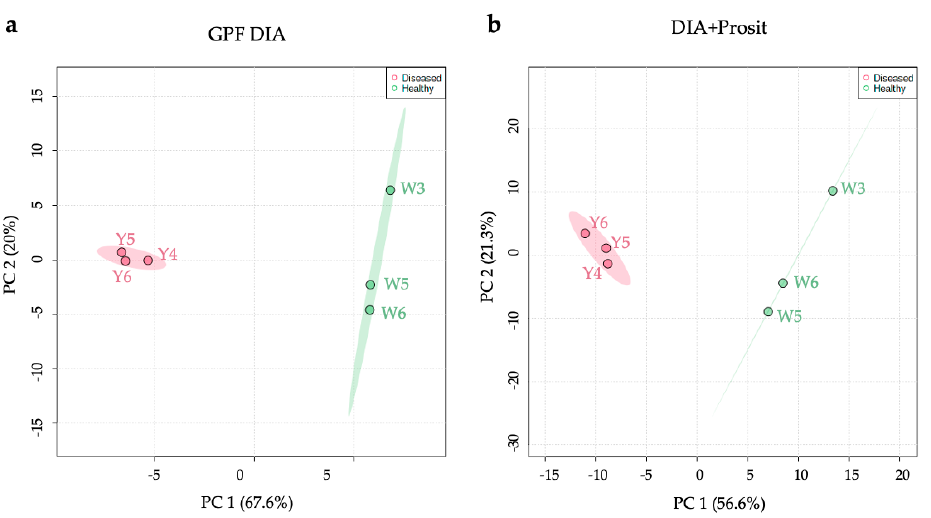
Figure 5. Principal component analysis (PCA) score plots of PC1 and PC2 and explained variances are shown. There was clear separation between diseased and healthy samples for V. vinifera using either ( a ) GPF DIA or ( b ) DIA + Prosit. W3, W5, and W6 are biological replicates of healthy plants, while Y4, Y5, and Y6 are diseased plants based on log 10 of the exclusive intensity of